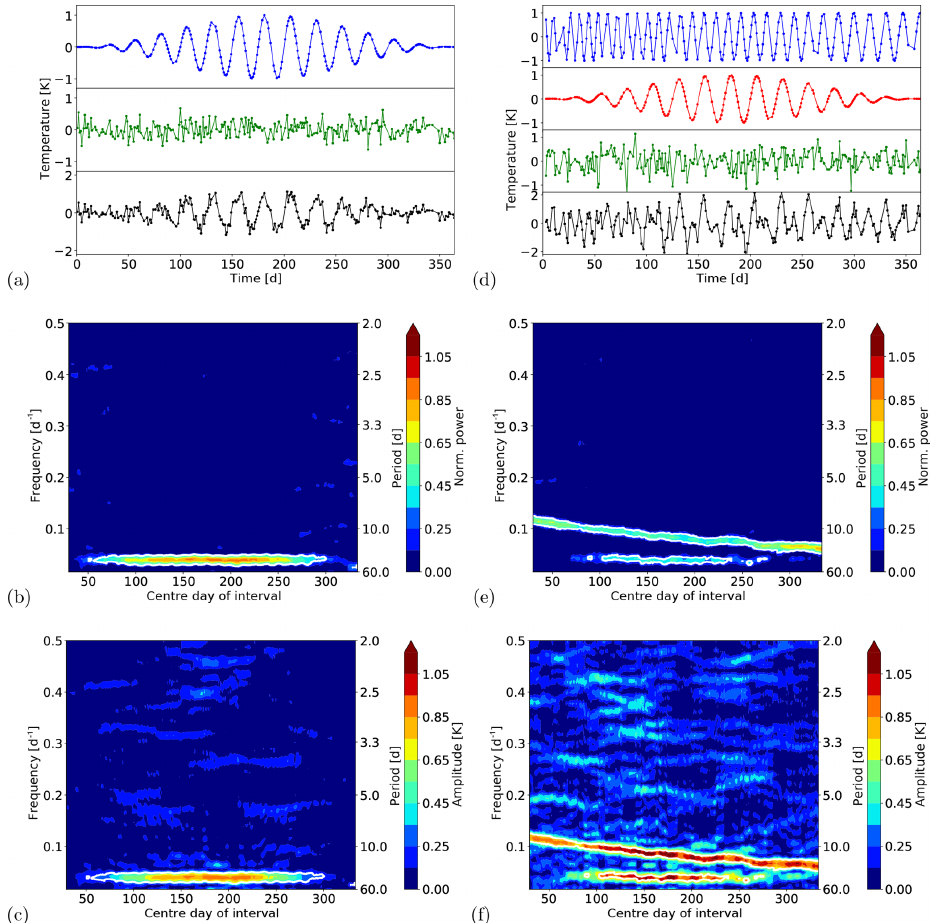
Figure 6. (a) Time series of a periodic signal with varying amplitude and additional noise and data gaps. The upper panel shows the signal, the middle panel the noise and the lower panel the sum of both. (b, c) Results for the normalised power and amplitude. The results are displayed at the centre day of the corresponding time window. The length of the time window was 60d. The white contours mark the significant results. (d) Time series of a periodic signal with increasing amplitude plus a periodic signal with varying amplitude and additional noise and data gaps. The upper two panels show the two signals, the third panel the noise, and the lower panel the sum of all. (e, f) Same as for (b, c)